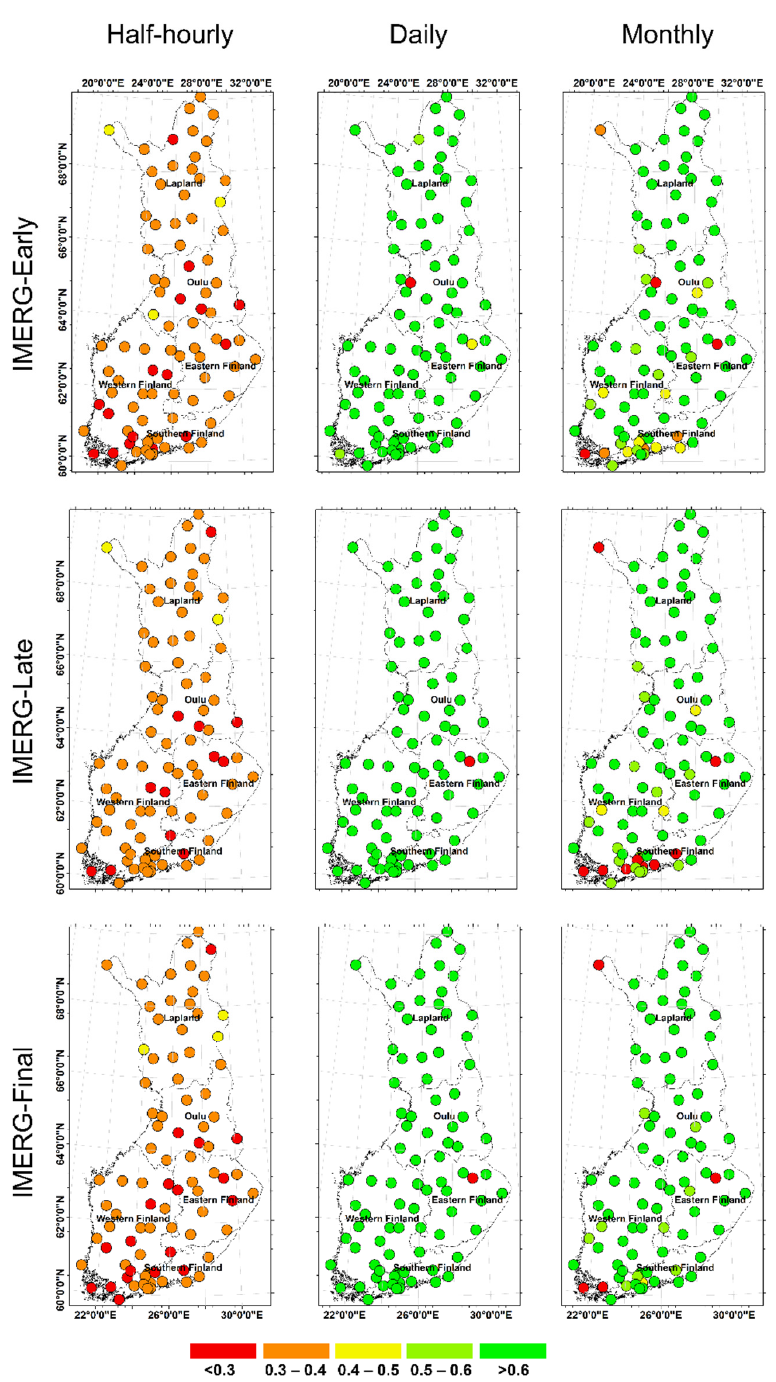
Figure 13. Spatial distributions of the half-hourly, daily, and monthly CC for IMERG-Early, IMERG- Late, and IMERG-Final.